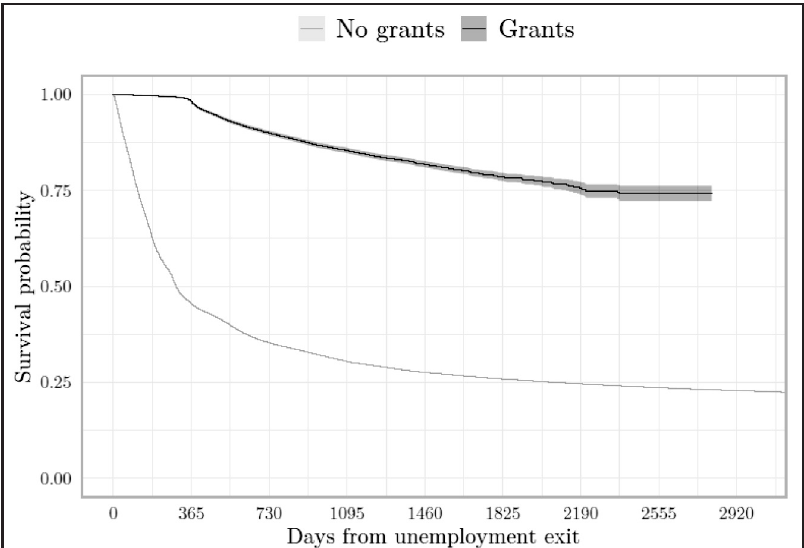
Kaplan–Meier estimates of employment survival: full